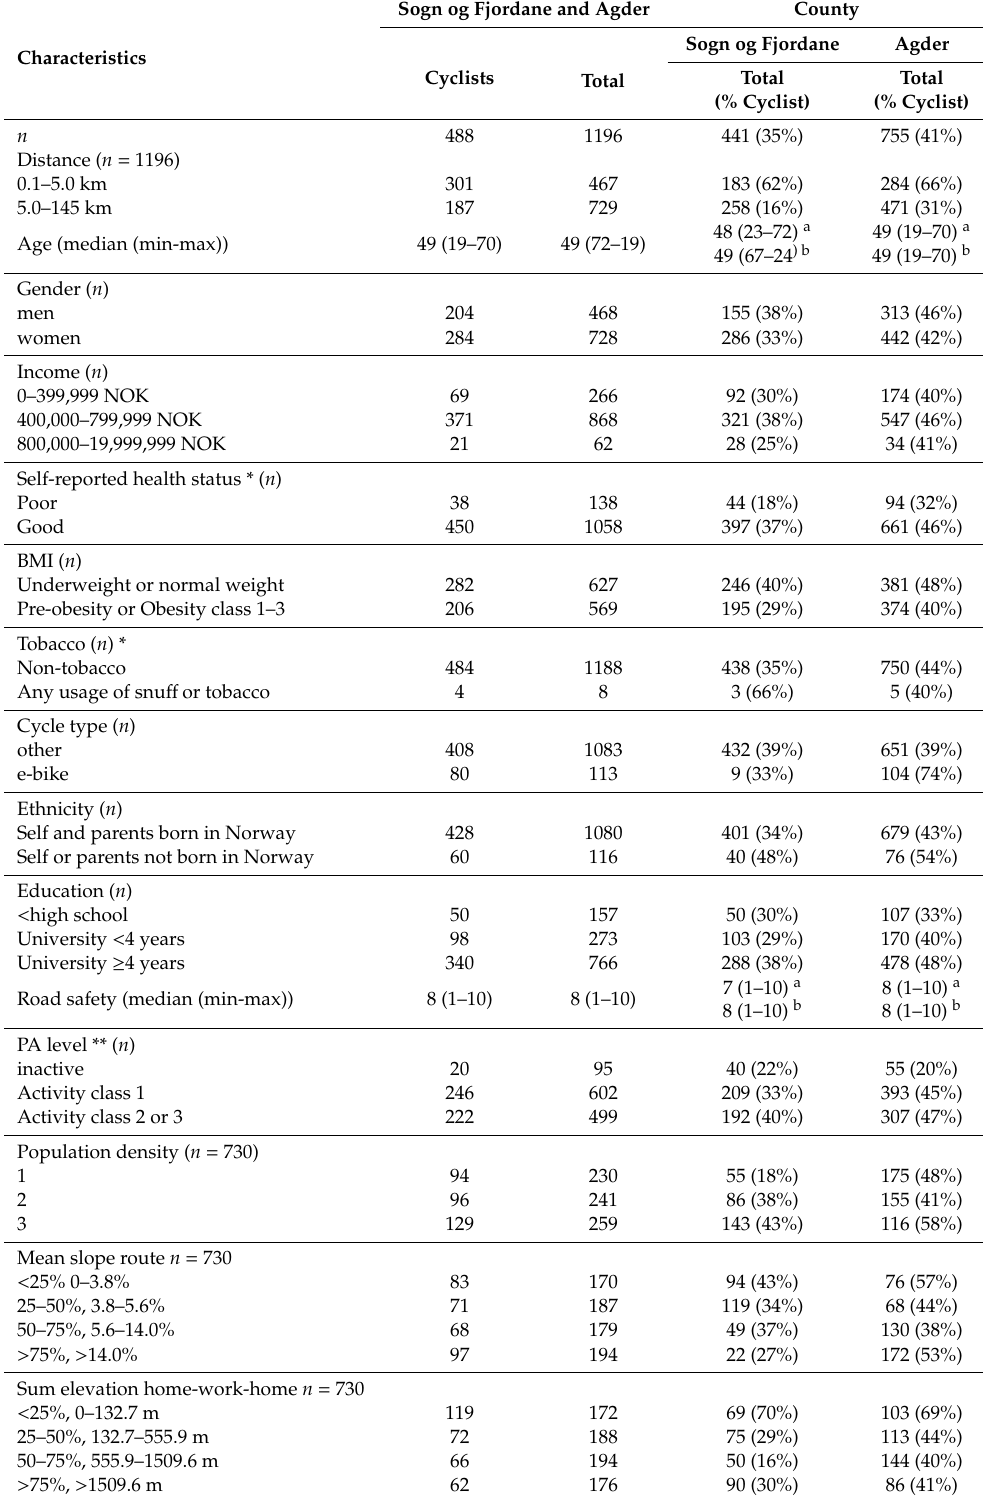
Table 1. Descriptive table of characteristics of participants, n =